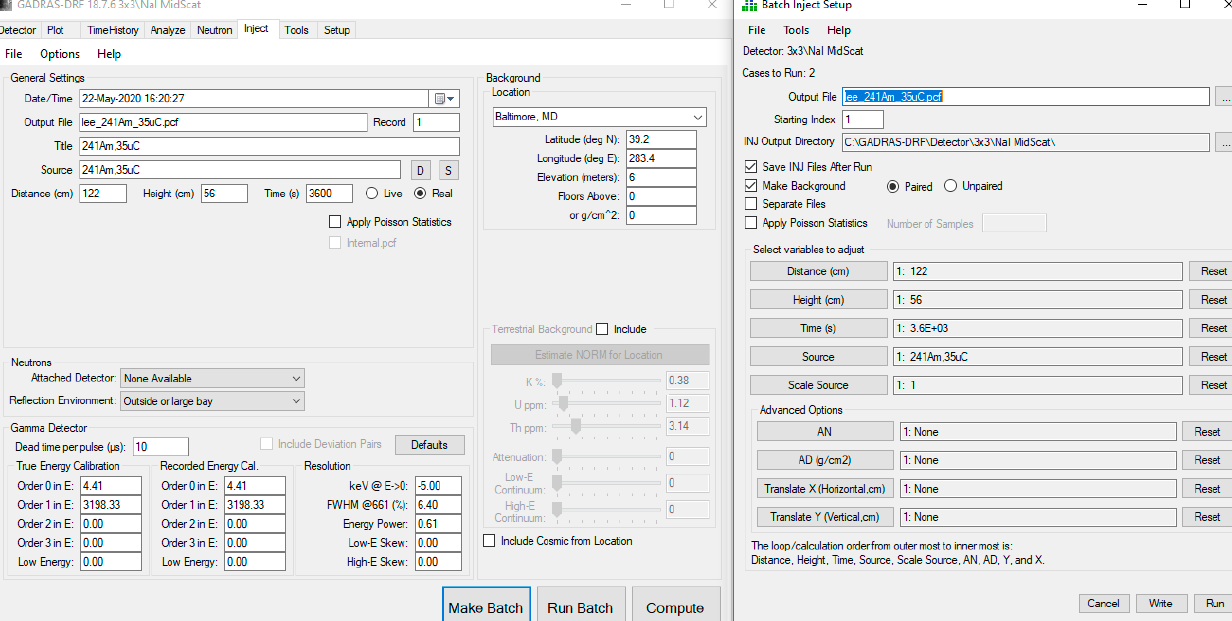
Figure 3. GADRAS Inject tool settings for generating individual radioactive source ‐ only spectra with NaI detector @ 122 cm, H = 56 cm.